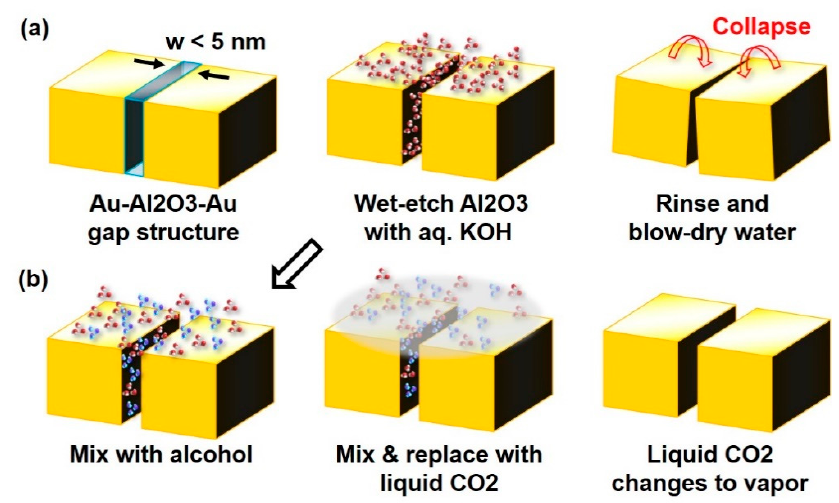
Figure 1. Schematic of the wet-etching process for metal–dielectric–metal gap structure, ( a ) without and ( b ) with the critical point drying (CPD) process. Due to the surface tension of the water, the gap collapses during the drying process when the gap is smaller than 5~10 nm. Using the CPD technique replaces the gap-filling material with liquid CO 2 and removes the surface tension, thereby enabling metallic nano-trenches with a gap width as small as 1.5 nm.